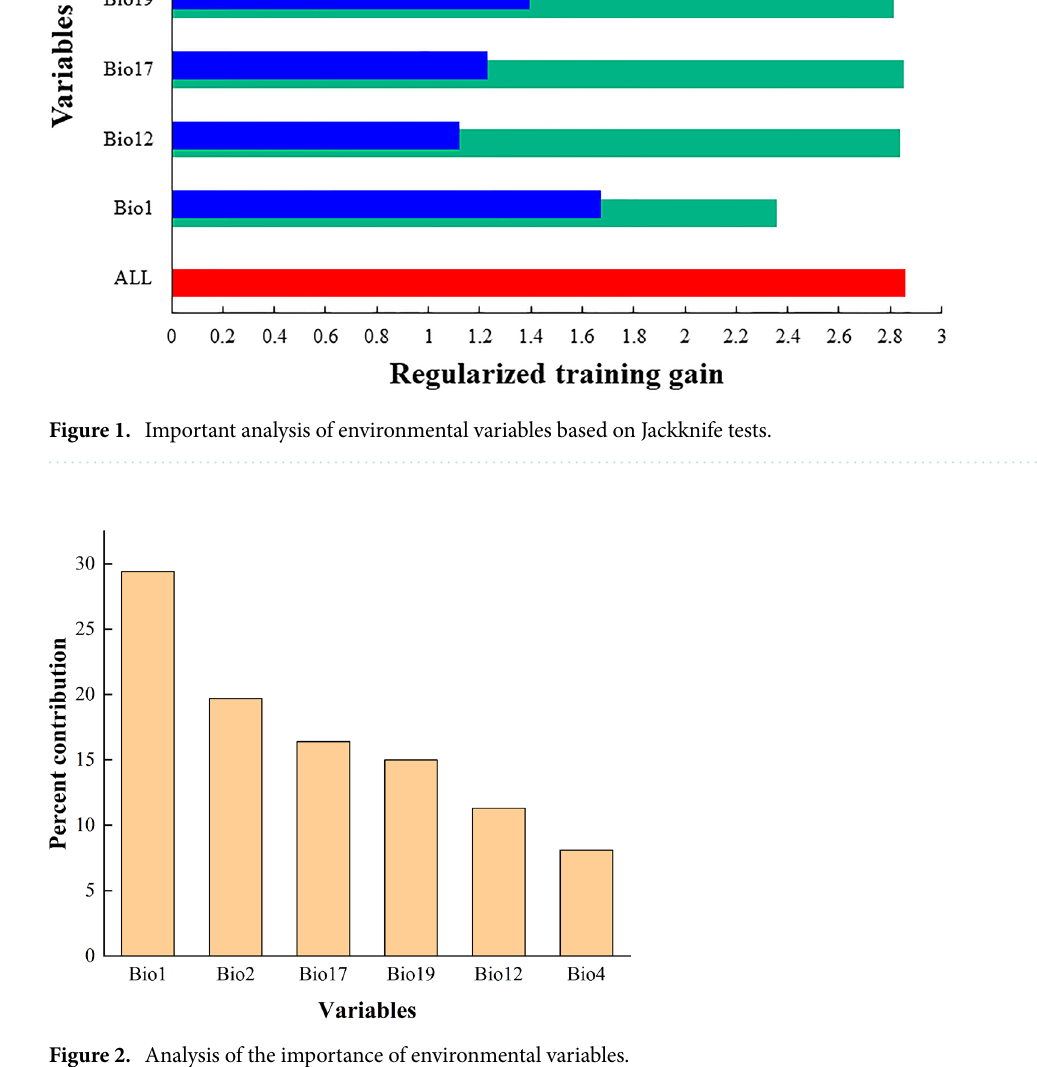
Figure 2. Analysis of the importance of environmental